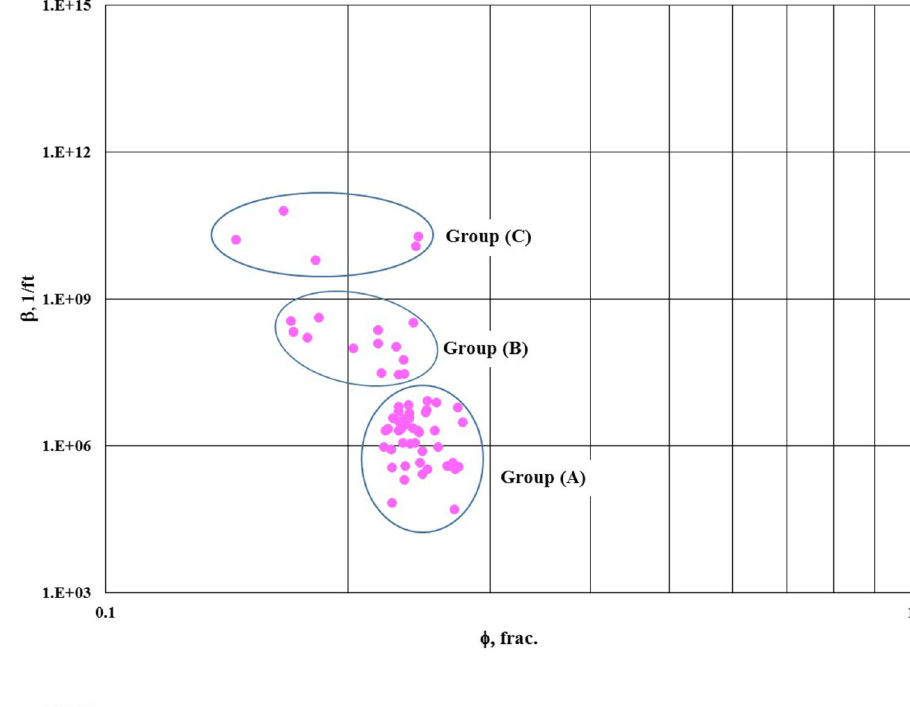
Fig. 3 Turbulence factor versus porosity (Amaefule et al.